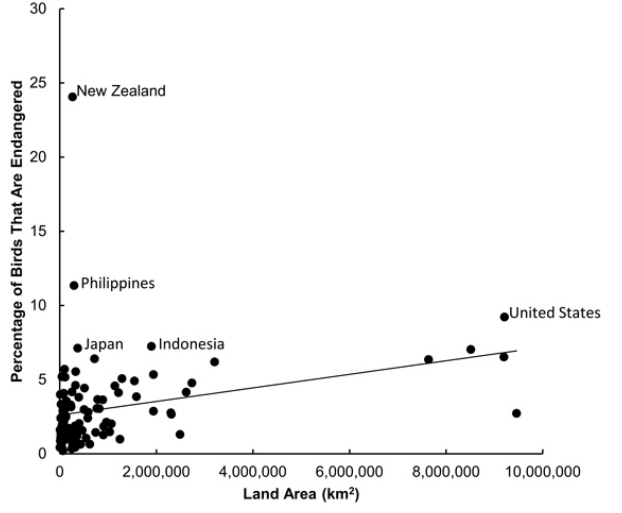
Fig. 4 . The model best explaining the proportion of invasive mammals was the per capita GDP in a country. The proportion of invasive mammals ranged from 0% to 70.46%, and per capita GDP ranged from $630 to $38,165. New Zealand and the United Kingdom were extreme